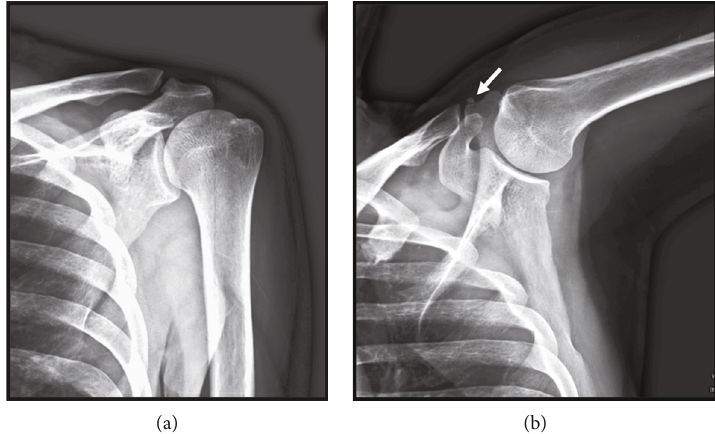
Figure 1: (a) Anteroposterior radiograph of the left shoulder showing a normal appearance. (b) Plain radiograph with the arm in an elevated position showing calci fi cation around the anterior acromion. The arrow indicates the calcium deposit.